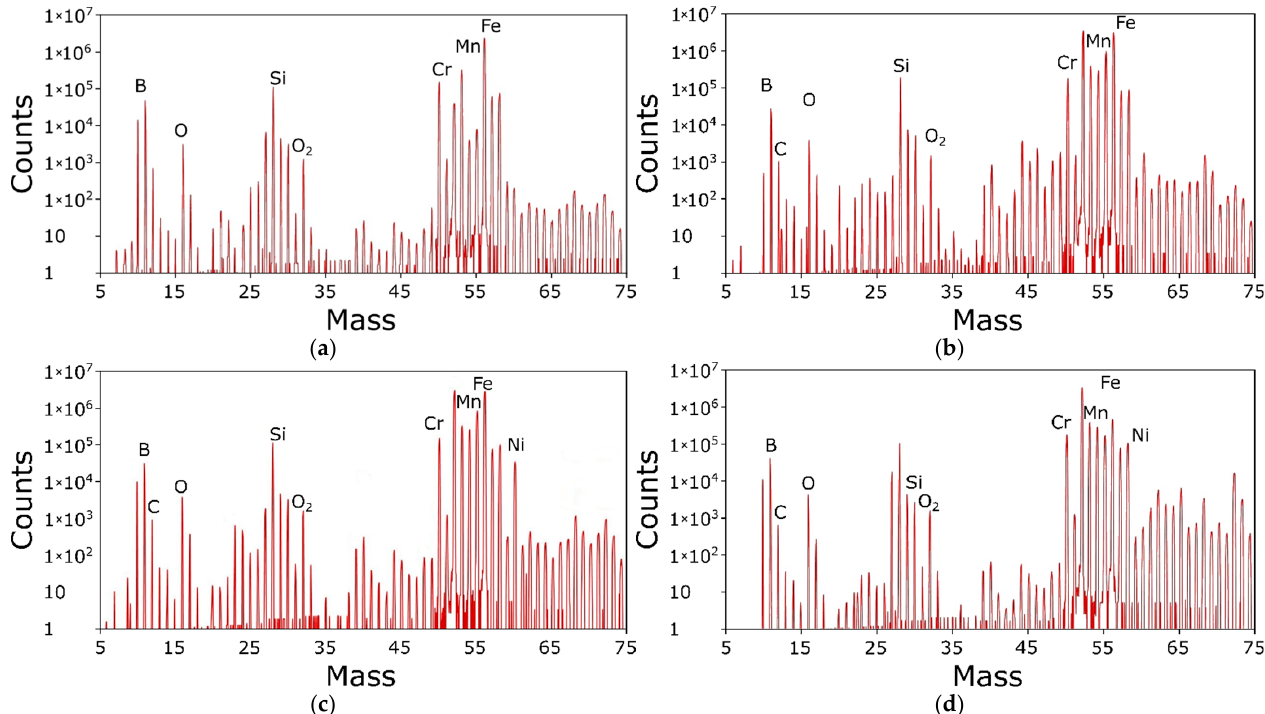
Figure 13. Mass spectra of the eutectic alloy coating surface at unit pressures of ( a ) 4 MPa, ( b ) 7 MPa, ( c ) 10 MPa, and ( d ) 15 MPa. Table 6. The SIMS data of the friction surface, wt.%. Contact Pressure, Element